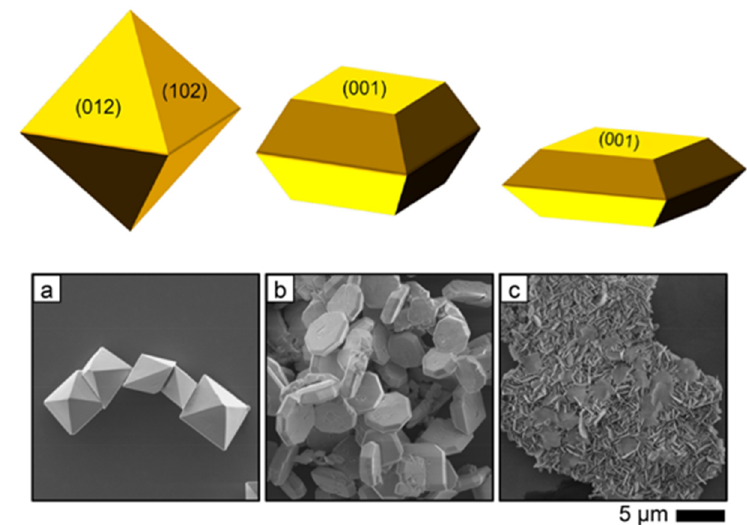
Figure 25. BiVO 4 synthesized ( a ) bipyramid, ( b ) thick platelets, and ( c ) thin platelet [87]. Reproduced with permission from Wang et al. Copyright © 2022 John Wiley & Sons, Inc.